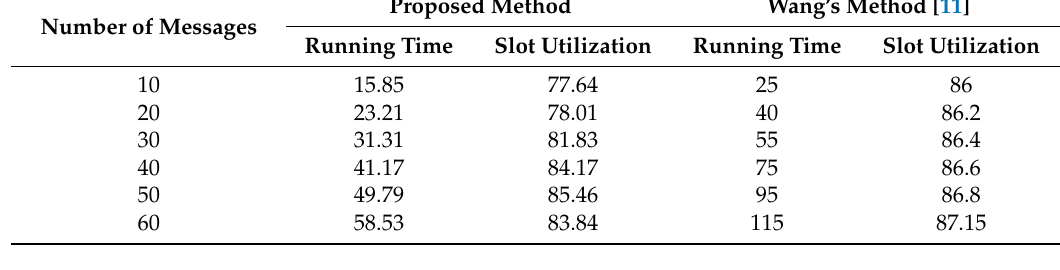
Figure 4. Comparison of running time with Li’s method.